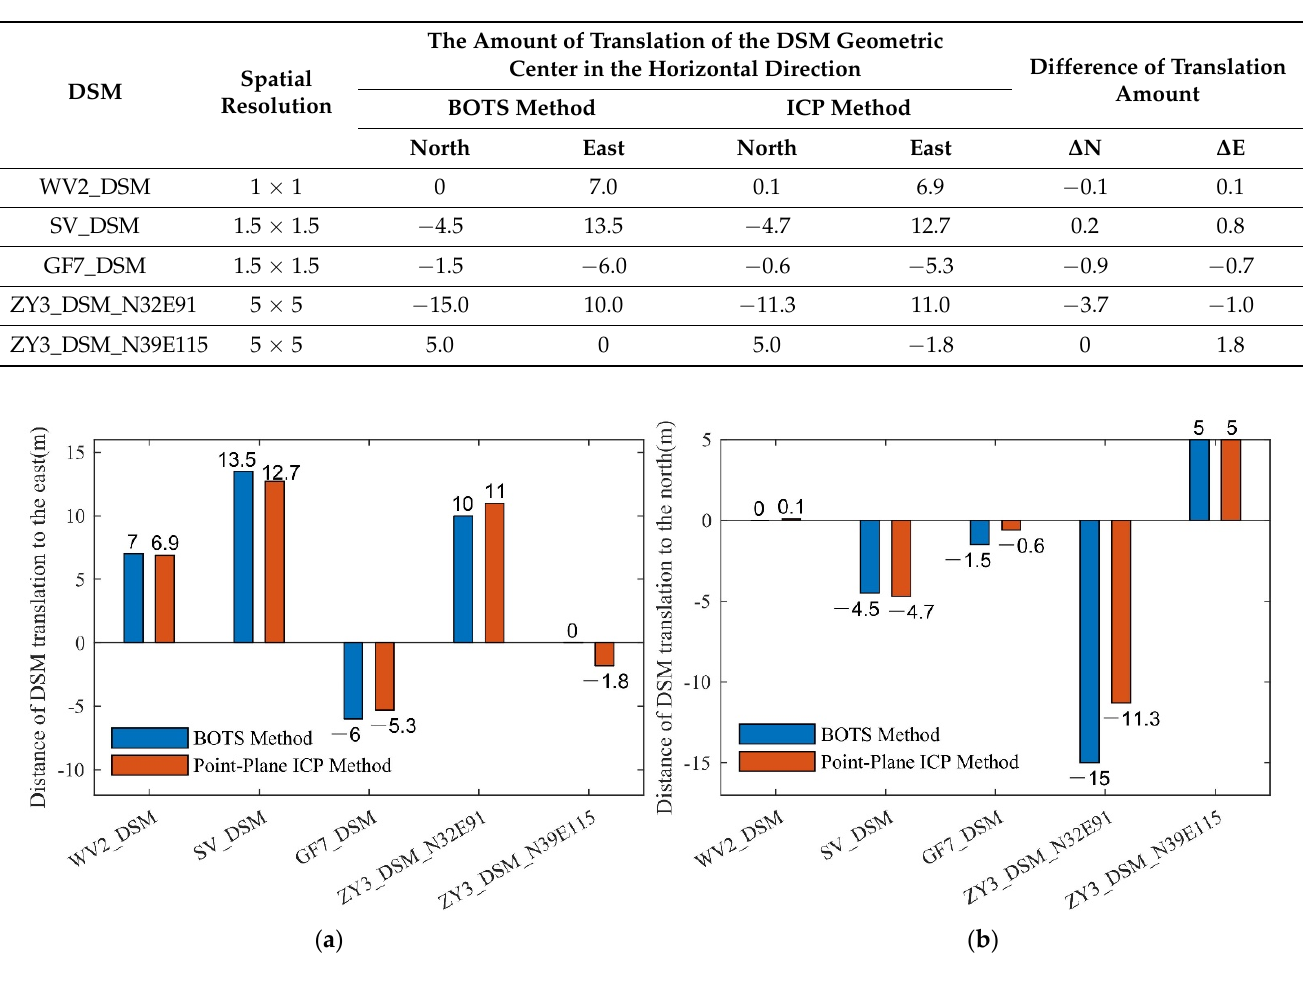
Table 3. The translation amount of the geometric center of the DSM in the horizontal direction after registration (unit: m).